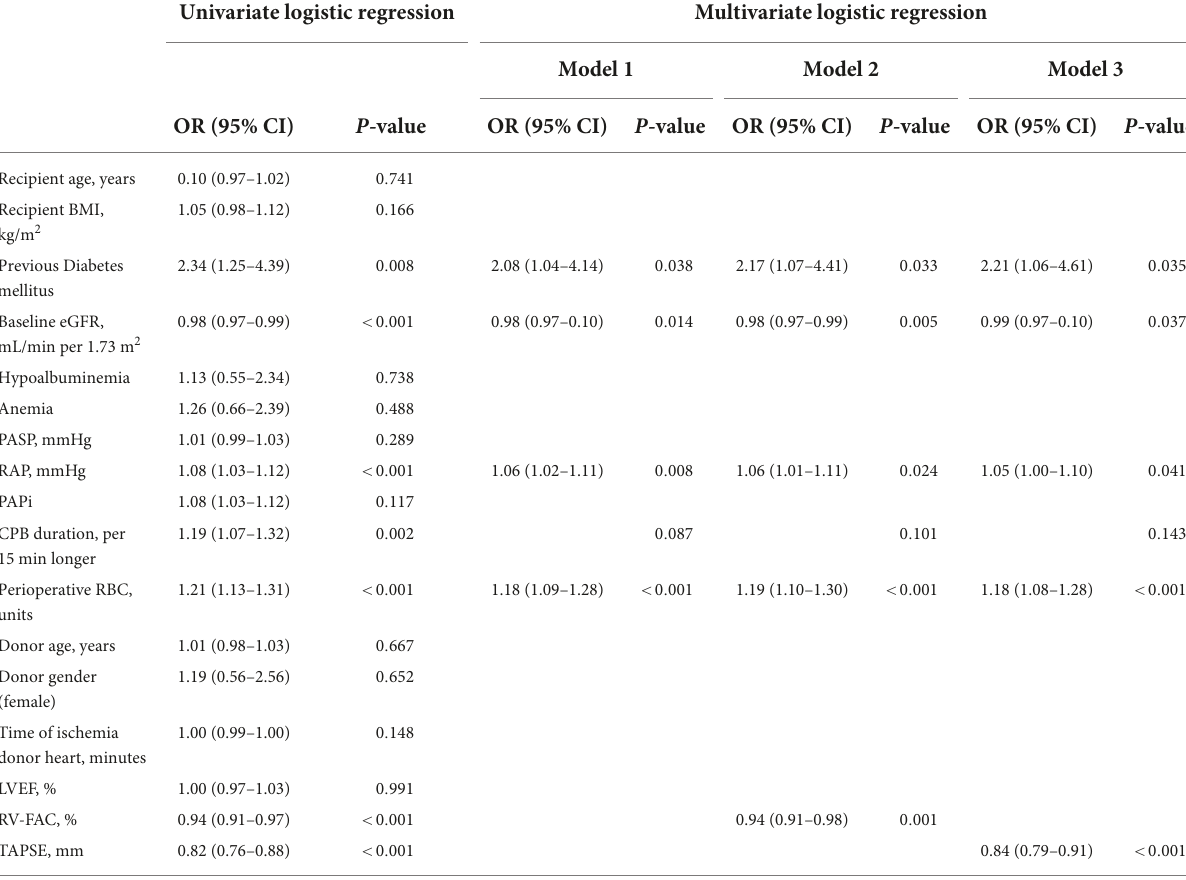
TABLE 3 Predictors of the postoperative moderate to severe AKI by the univariate and multivariate logistic regression models. Univariate logistic regression Multivariate logistic regression Model 1 Model 2 Model 3 P -value OR (95%